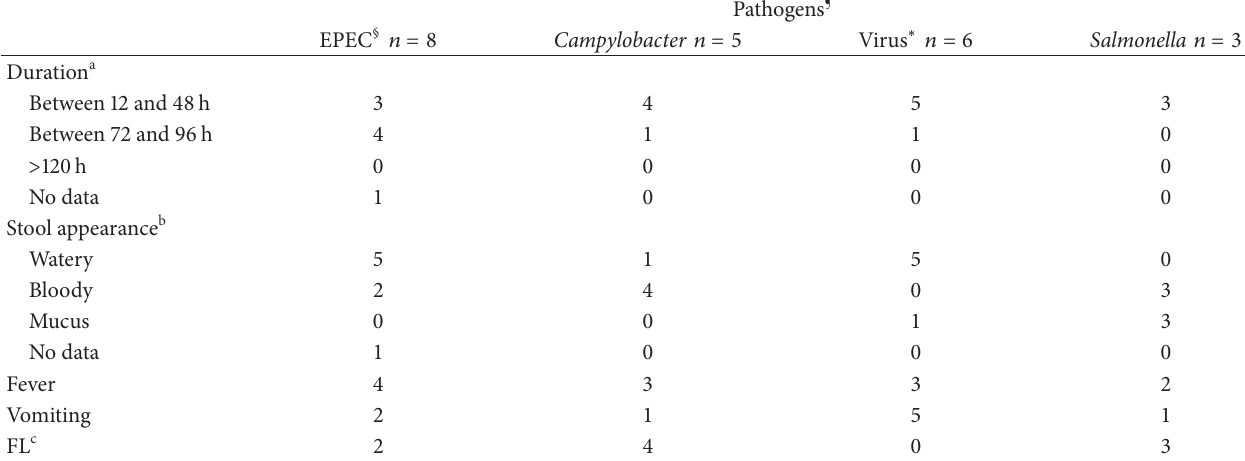
Table 3: Clinical data of the children with diarrhea by EPEC, Campylobacter , viruses or Salmonella